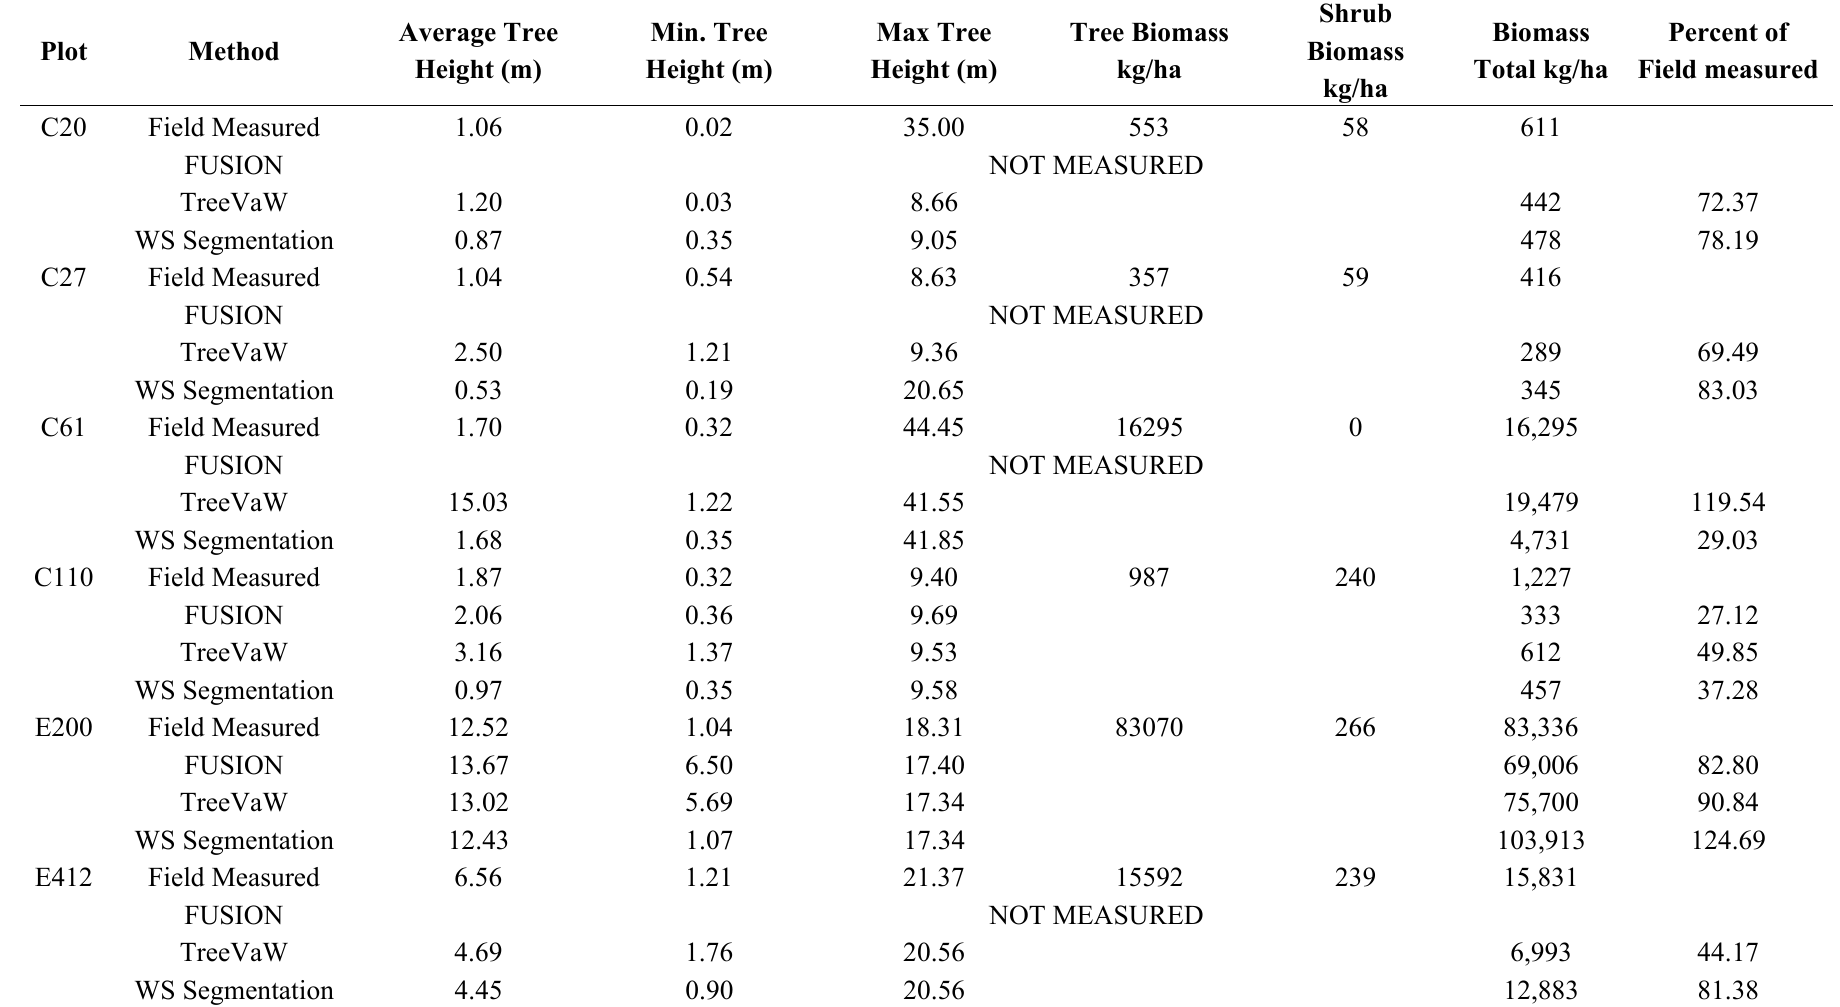
Table 14. TAGB estimates by plot using BIOPAK. Field measurement data calculated per tree by species. LiDAR calculations by feature based on large Douglas-fir (DBH ≥ 0.13 m) and small Douglas-fir (DBH < 0.13